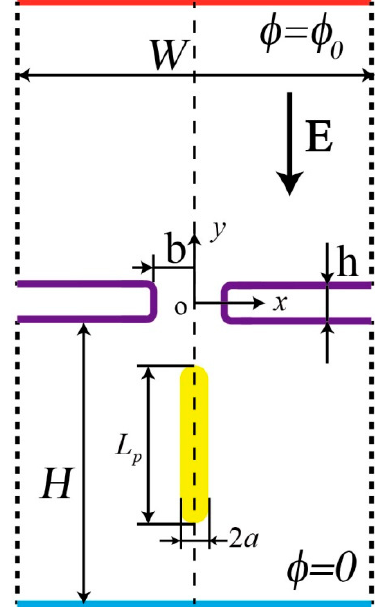
Figure 1. Schematics of a cylindrical particle passing through a nanopore.